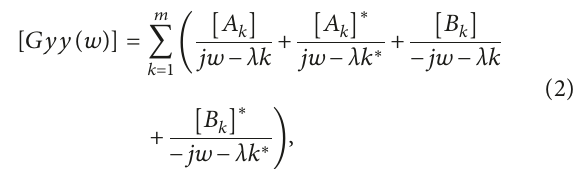
Adjacent to the